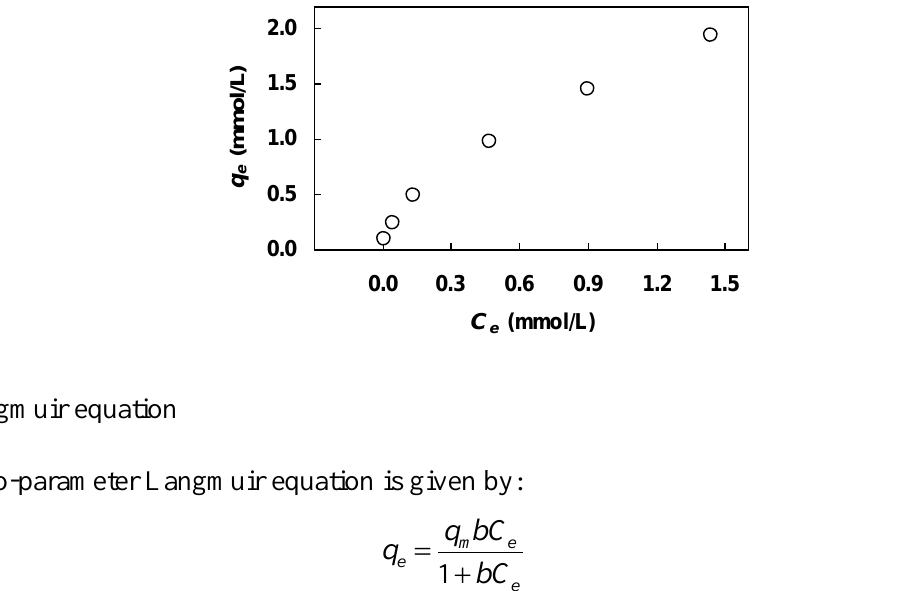
Figure 1. Experimental isotherm for lead biosorption on orange peels; data of Schiewer and Balaria